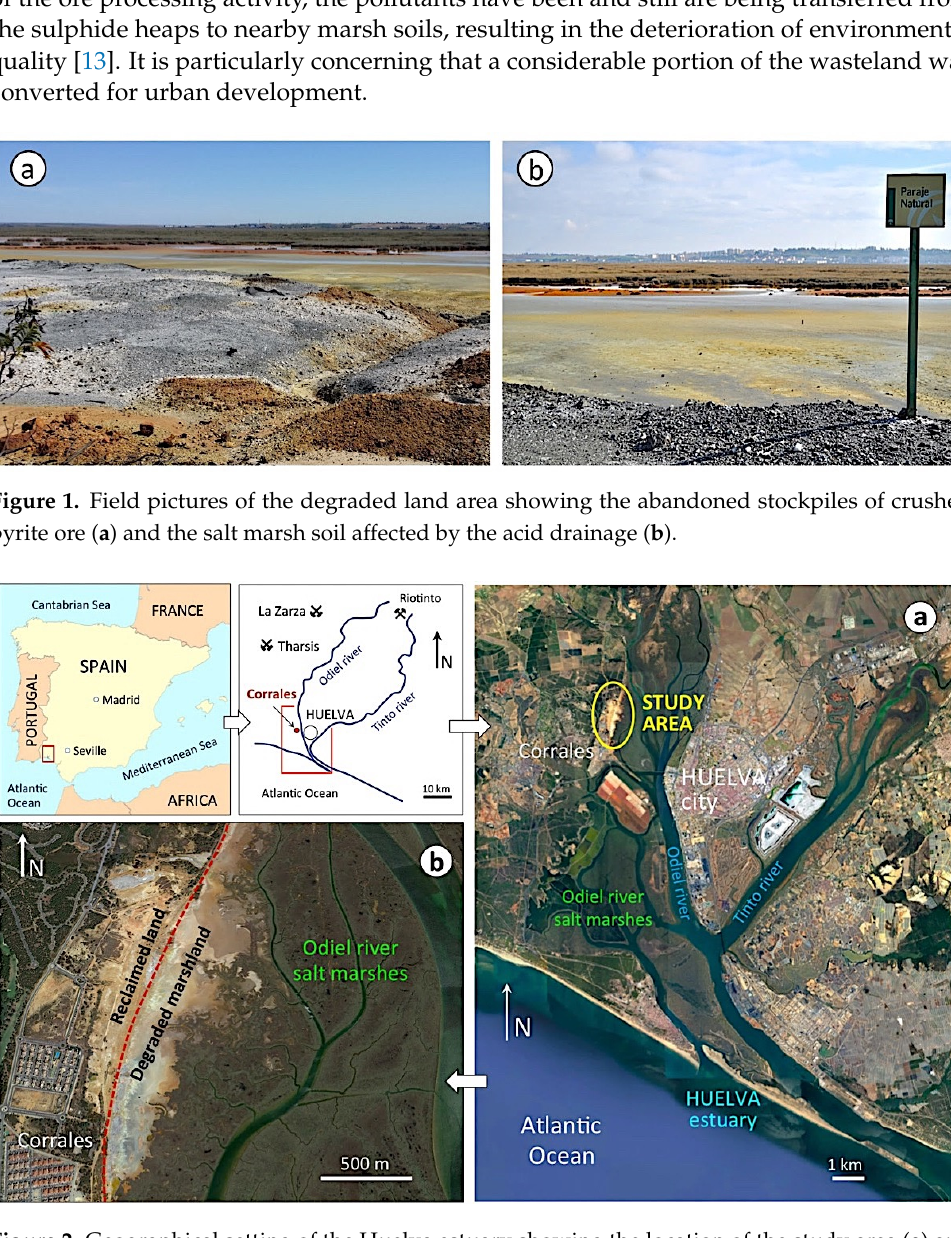
Figure 2. Geographical setting of the Huelva estuary showing the location of the study area ( a ) and the salt marsh soil impacted by past mineral handling activities ( b ).